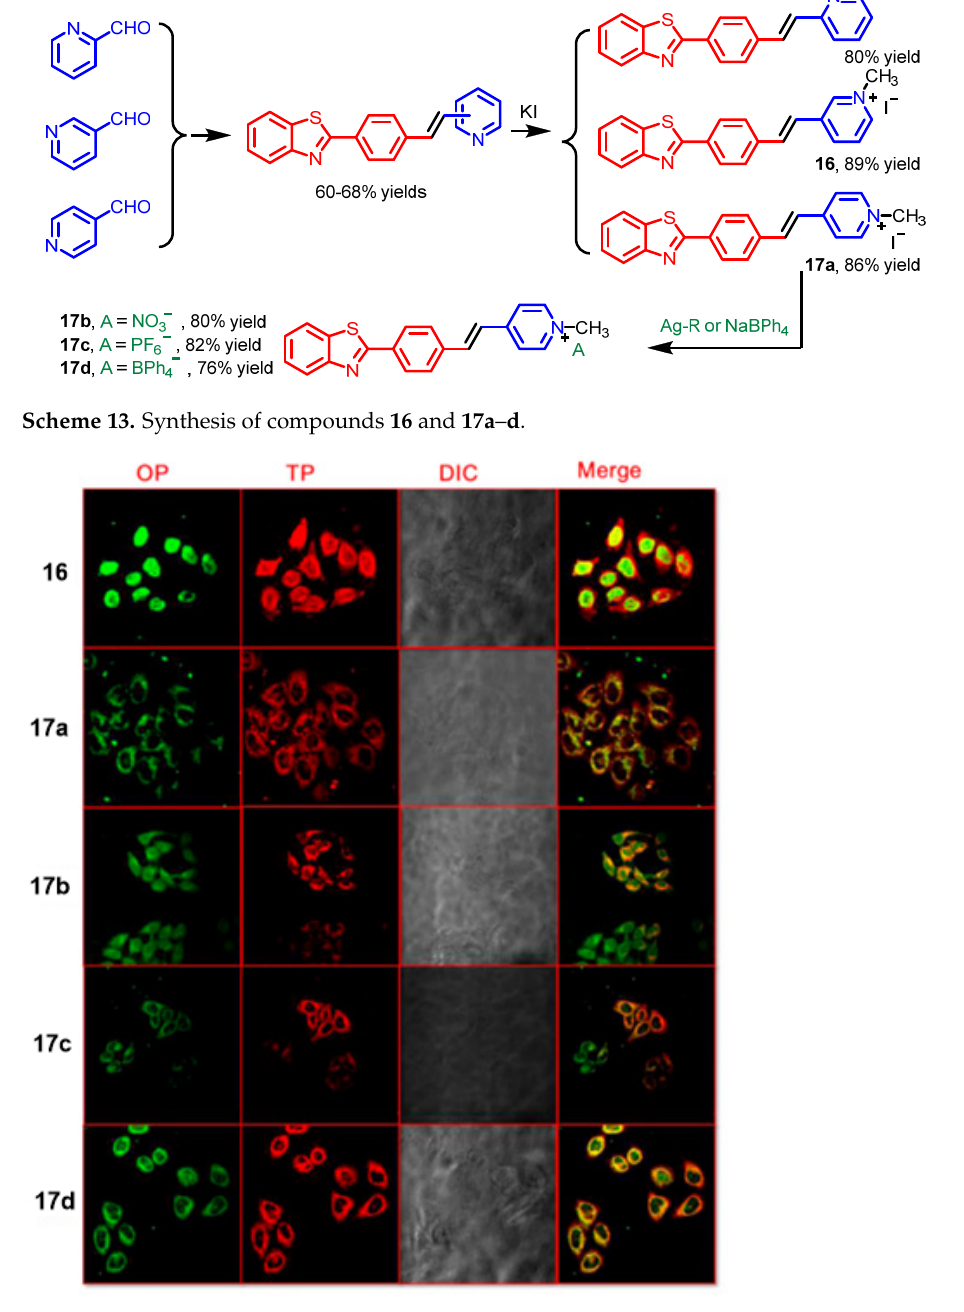
Figure 14. One- and two-photon fluorescence images of Hela cells stained with compounds 16 and 17a – d . Adapted from [42].